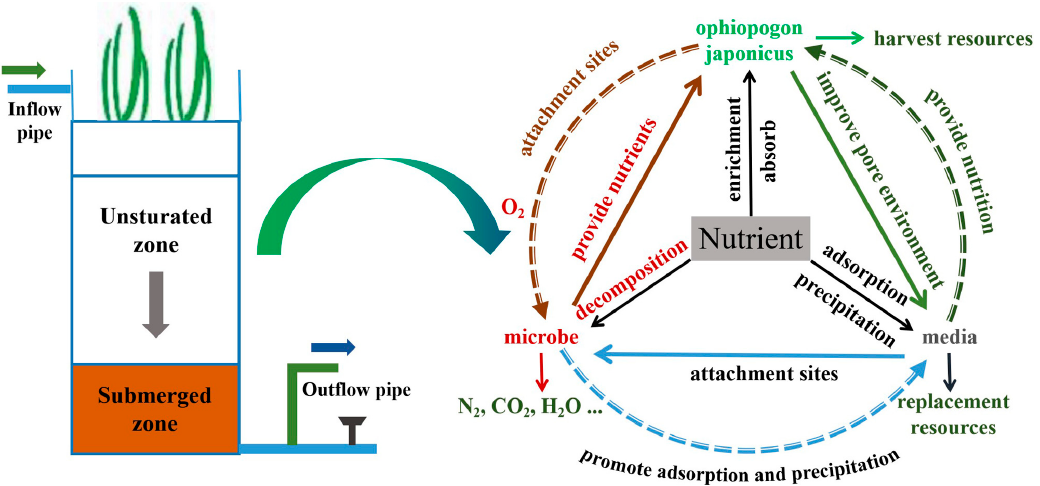
Figure 15. Mechanism of pollutant removal combined flora-microbe-media in